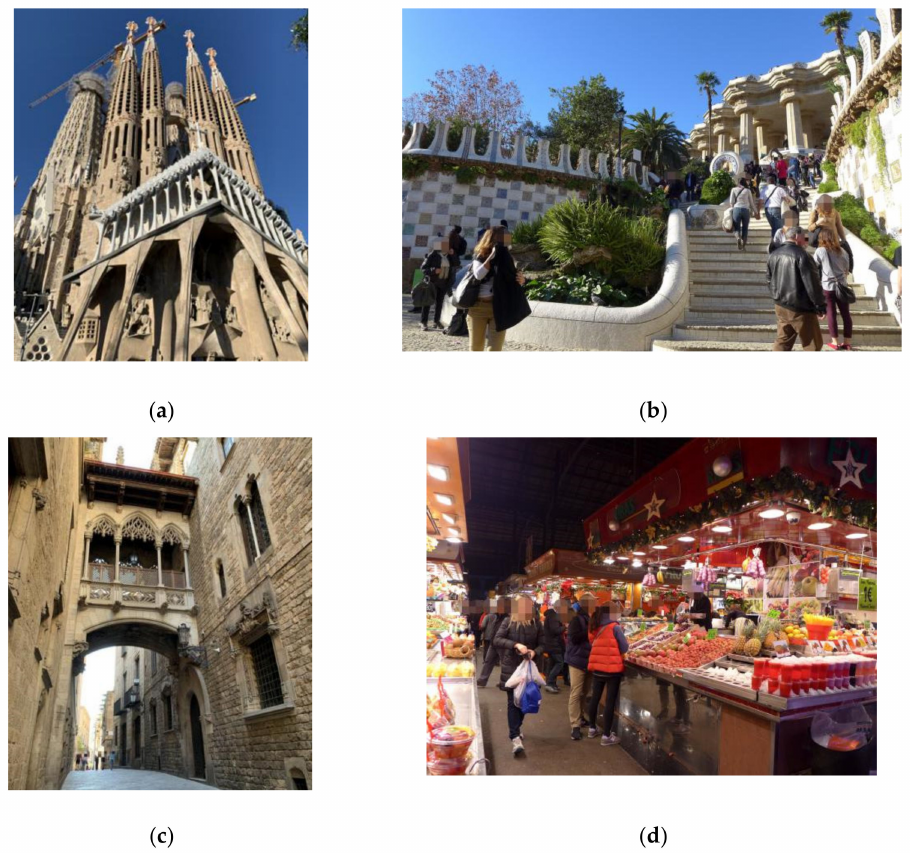
Figure 3. ( a ) Sagrada Familia. Source: own preparation. ( b ) Park Güell. Source: own preparation. ( c ) Barrio G ó tico. Source: own preparation. ( d ) La Boquer í a. Source: own